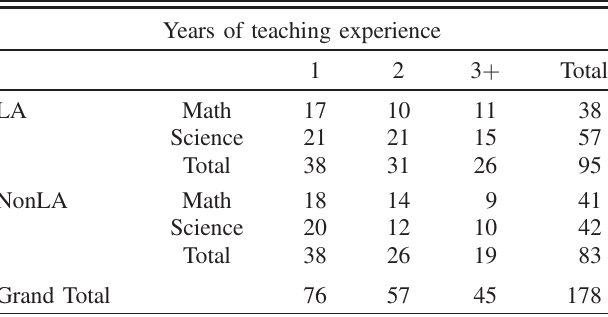
TABLE II. Number of observations by years of teaching